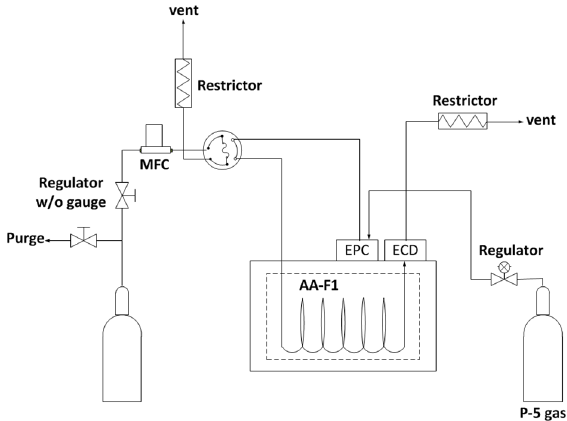
Figure 1 Schematic diagram of the experimental setup. Using the regulator without a gauge, the unwanted contribution of gases moored in the dead volume was expected to be reduced. Two restrictors virtually isolated the instrument from variation in the ambient conditions of the lab and, therefore, lead to reasonable repeatability of the measurement results. EPC and ECD stand for the electronic pressure controller and electron capture detector, respectively. A series of measurement was performed while manual-switching left cylinder from sample and standard..